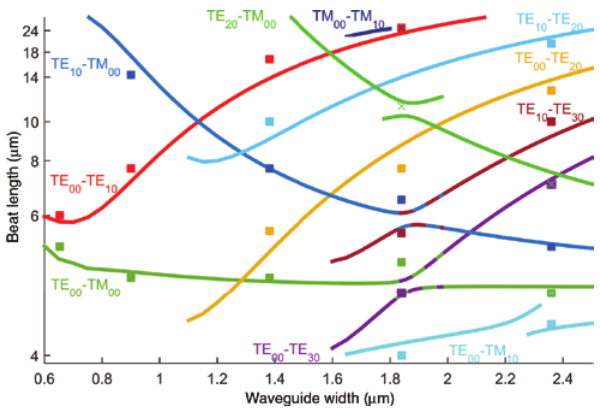
Figure 3: Computationally generated dispersion curves showing beat periodicity as a function of waveguide width. Markers indicate the experimentally observed periodicities and correspond well to prediction.